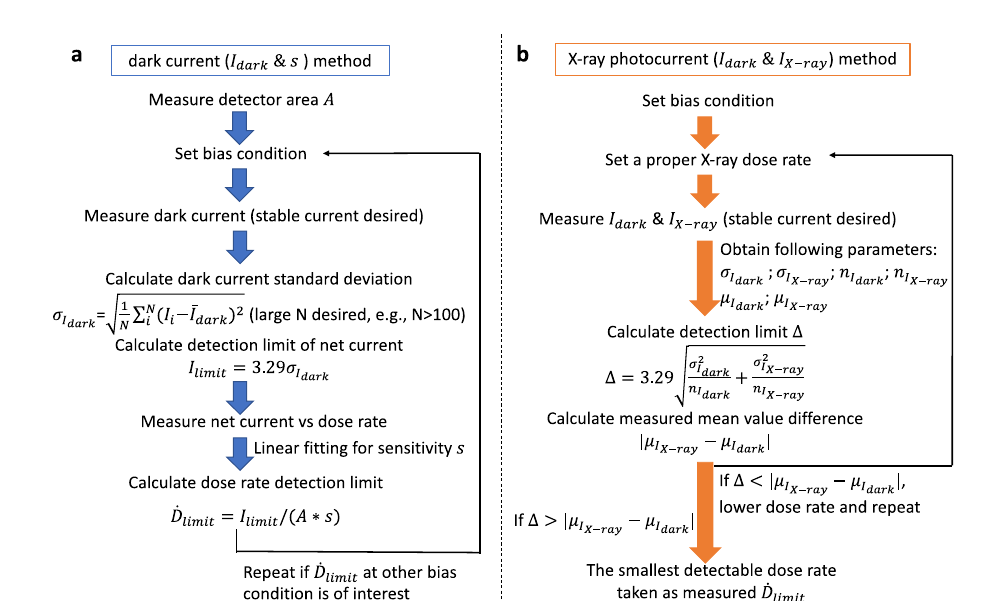
is the standard deviation of the photocurrent under X-ray irradiation I X – ray . X (cid:3) ray I X – ray and I dark , respectively. μ μ I X (cid:3) ray and I dark are the measured mean value of